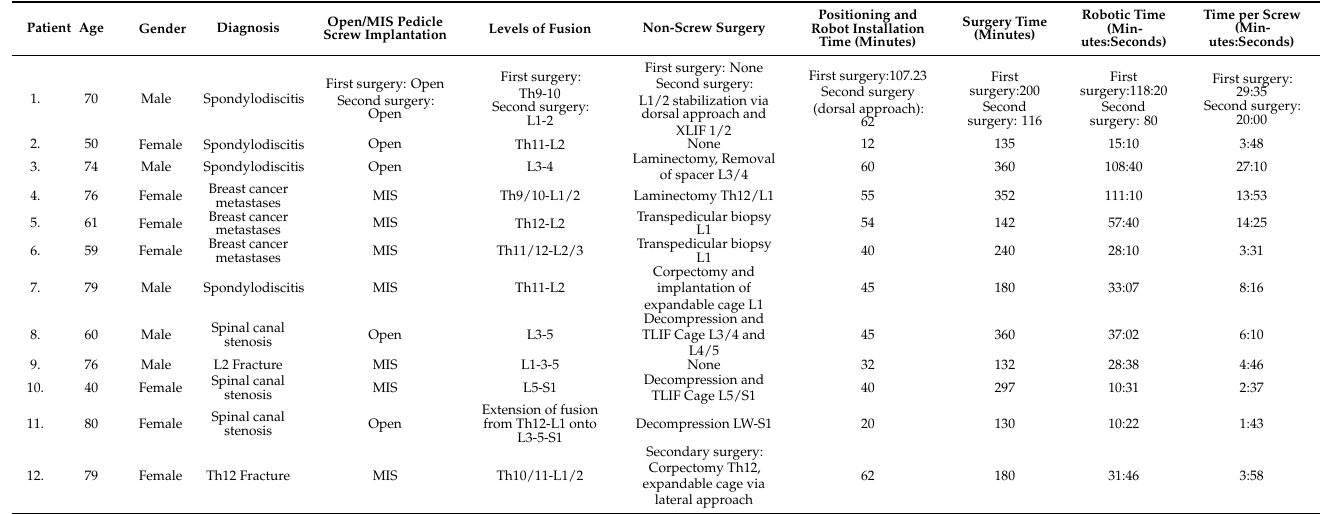
Table 1. General characteristics of the